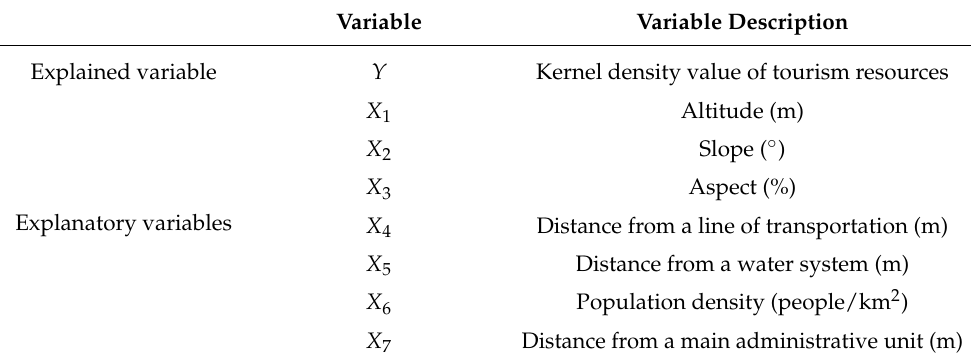
Table 4. Variable and variable